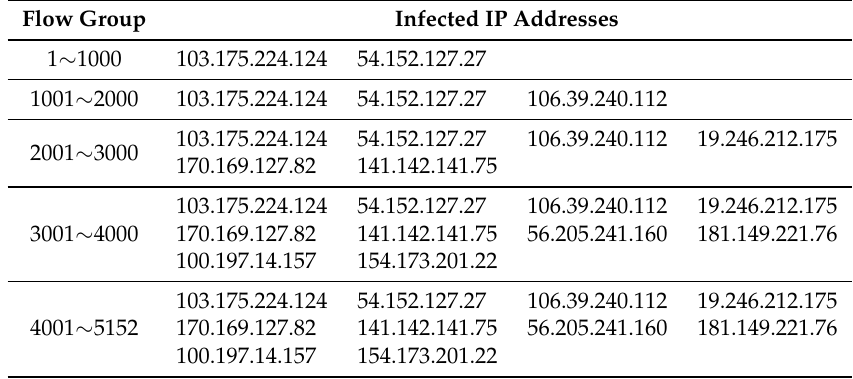
Table 2. Infected IP addresses in the dataset for each flow group under the TCP worm simulation